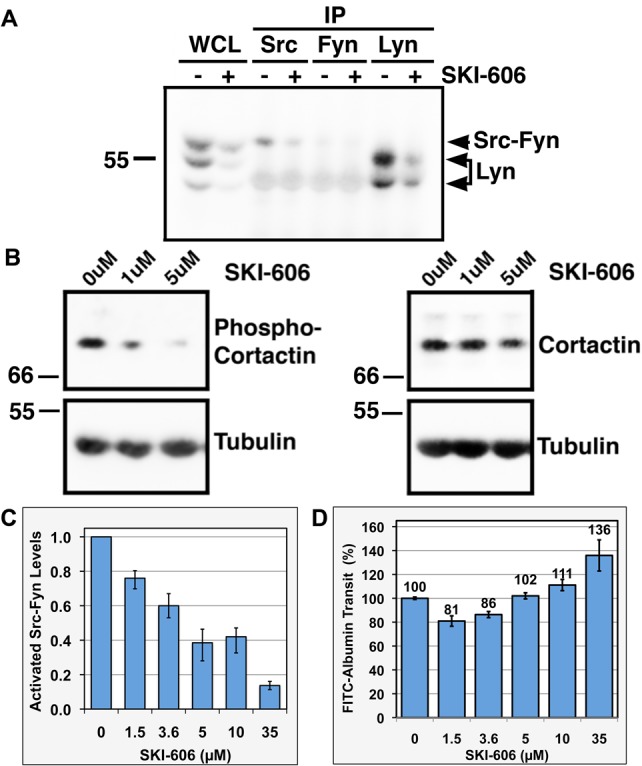
Effect of Src family of kinases inhibitor SKI-606 on the transcellular permeability of retinal endothelial cells knocked down for Tbdn. (A) RF/6A retinal endothelial cells stably knocked down for Tbdn were treated with 1.5 μM of SKI-606 or vehicle for 24 h. Whole cell lysates (WCL) and c-Src, Fyn and Lyn immunoprecipitations (IP) were analyzed by western blots with a phospho-Src family (Tyr416) antibody (shown) or with either c-Src, Fyn or Lyn antibodies to confirm efficacy of immunoprecipitations (not shown). Activated SFK western blot of c-Src and Fyn immunoprecipitations revealed a non-specific band at 54 kDa. Representative results of 4 experiments are shown. (B) Retinal endothelial cells stably knocked down for Tbdn were treated with indicated amount of SKI-606 or vehicle for 20 h. Whole cell lysates were analyzed by western blotting for phospho-Cortactin (Tyr421), Cortactin and Tubulin as loading controls. Representative results of at least 3 experiments are shown. (C) Relative levels of activated c-Src-Fyn (represented in panel A WCL lane, top band 60 kDa) quantified by western blot analysis for phospho-Src family (Tyr416) of RF/6A retinal endothelial cells stably knocked down for Tbdn treated with indicated amount of SKI-606 under high cell density conditions (optimal permeability assay conditions). Data is expressed as mean±s.e.m. of 4 experiments. (D) Percentages of FITC-Albumin transit across a monolayer of retinal endothelial cells stably knocked down for Tbdn treated with various concentrations of SKI-606 as indicated or with vehicle only (0 µM). Vehicle treated cells are significantly different from all SKI-606 treated cells (P<0.02) except 5 µM SKI-606. Data is expressed as mean±s.e.m. of 6 experiments.